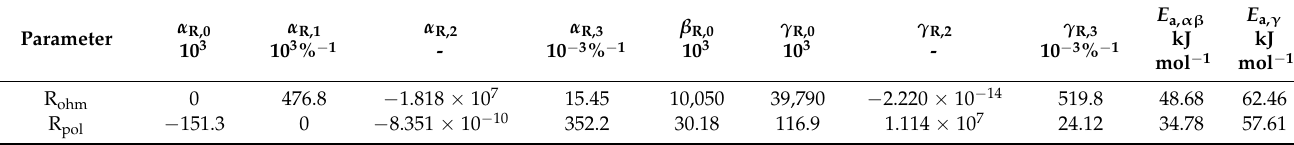
Table 4. The 4D fit model parameter for R ohm and R pol